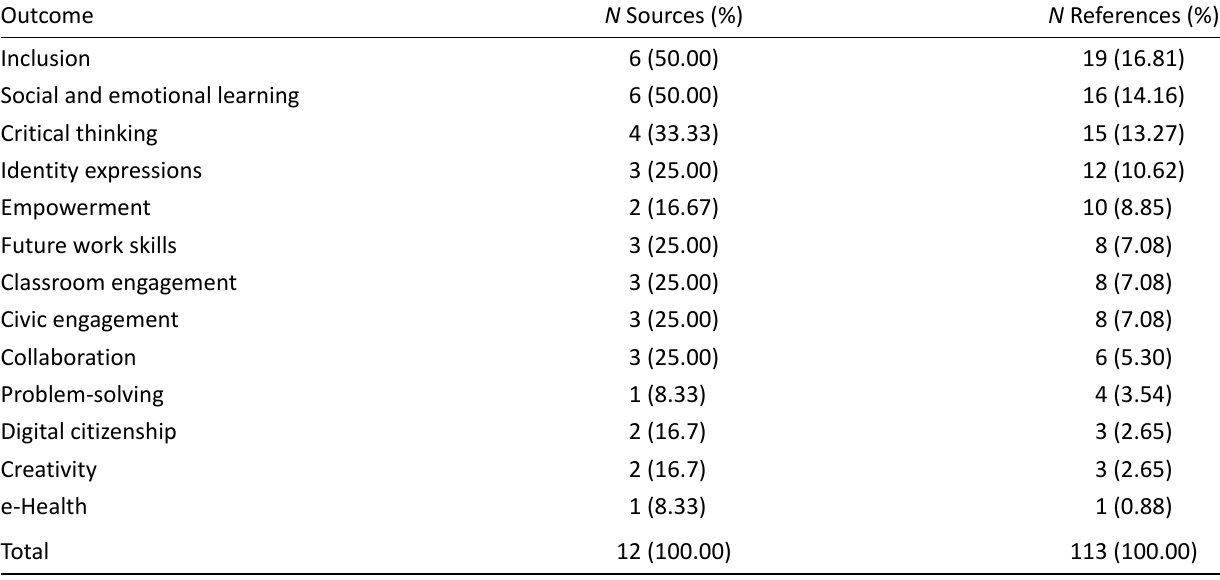
Table 5. Positive outcomes of media literacy in the sample and number of references ( N = 12).